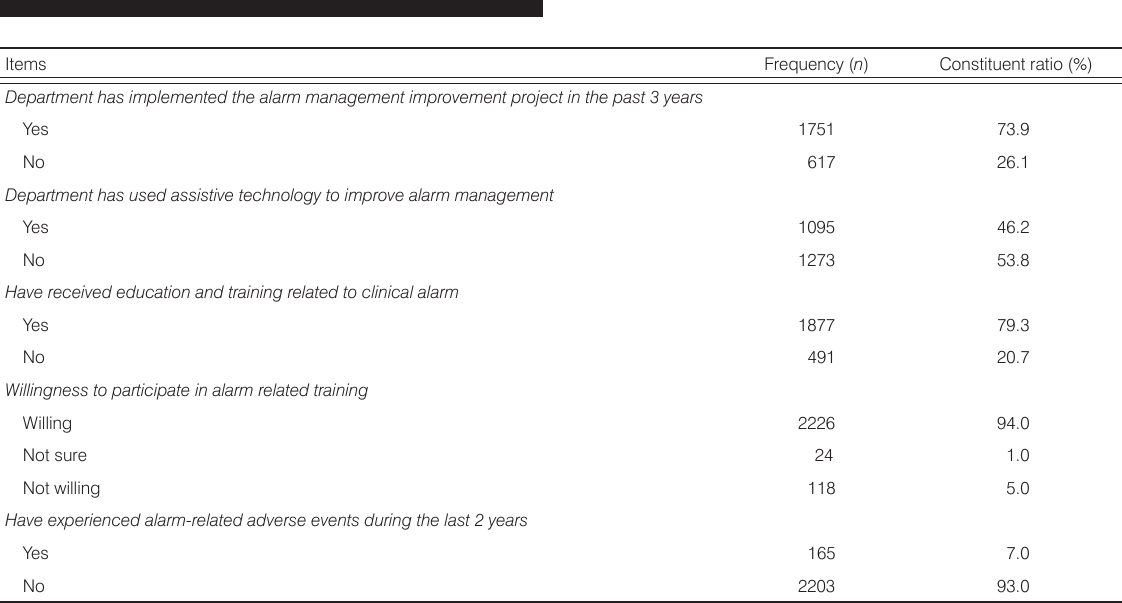
Table 2. General demographic data of surveyed nurses ( n =